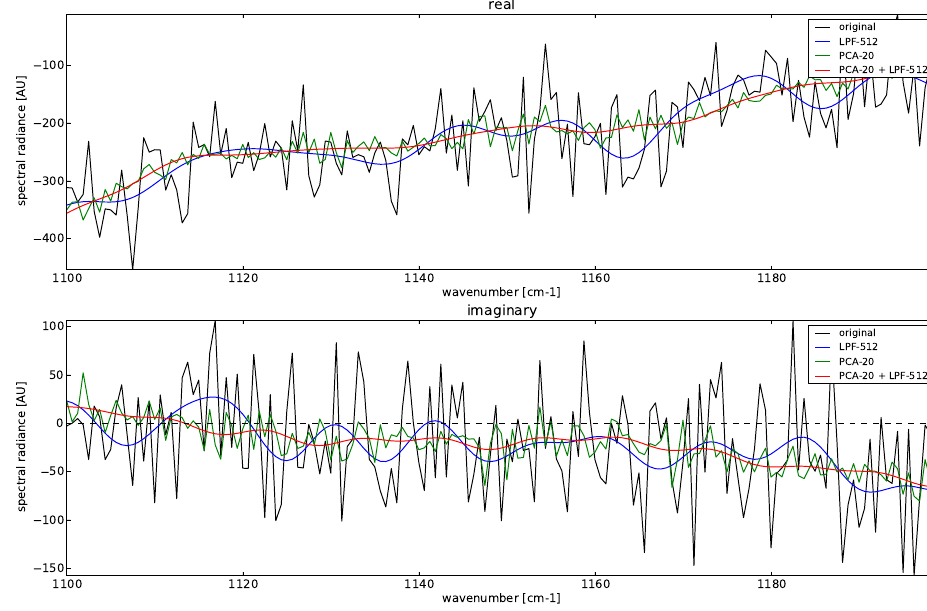
Figure 13. Comparison between the PCA, low-pass and combined noise suppression methods (cf. Fig. 12) in the spectral range between 1100 and 1200cm − 1 . The pure low-pass method retains higher amounts of low-frequency noise, which manifest as slow oscillations in the spectrum. The PCA method subtracts noise variance irrespective of frequency (see also Fig. 15).